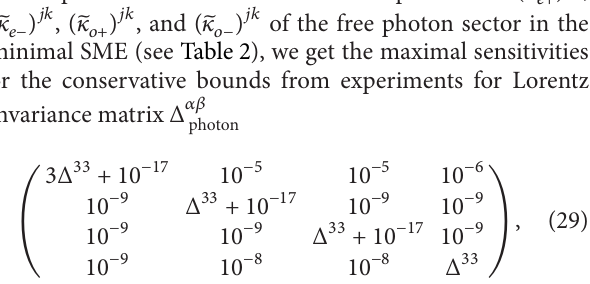
𝑗𝑘 𝑗𝑘 𝑗𝑘 , (̃𝜅 𝑒− ) , (̃𝜅 𝑜+ ) , and